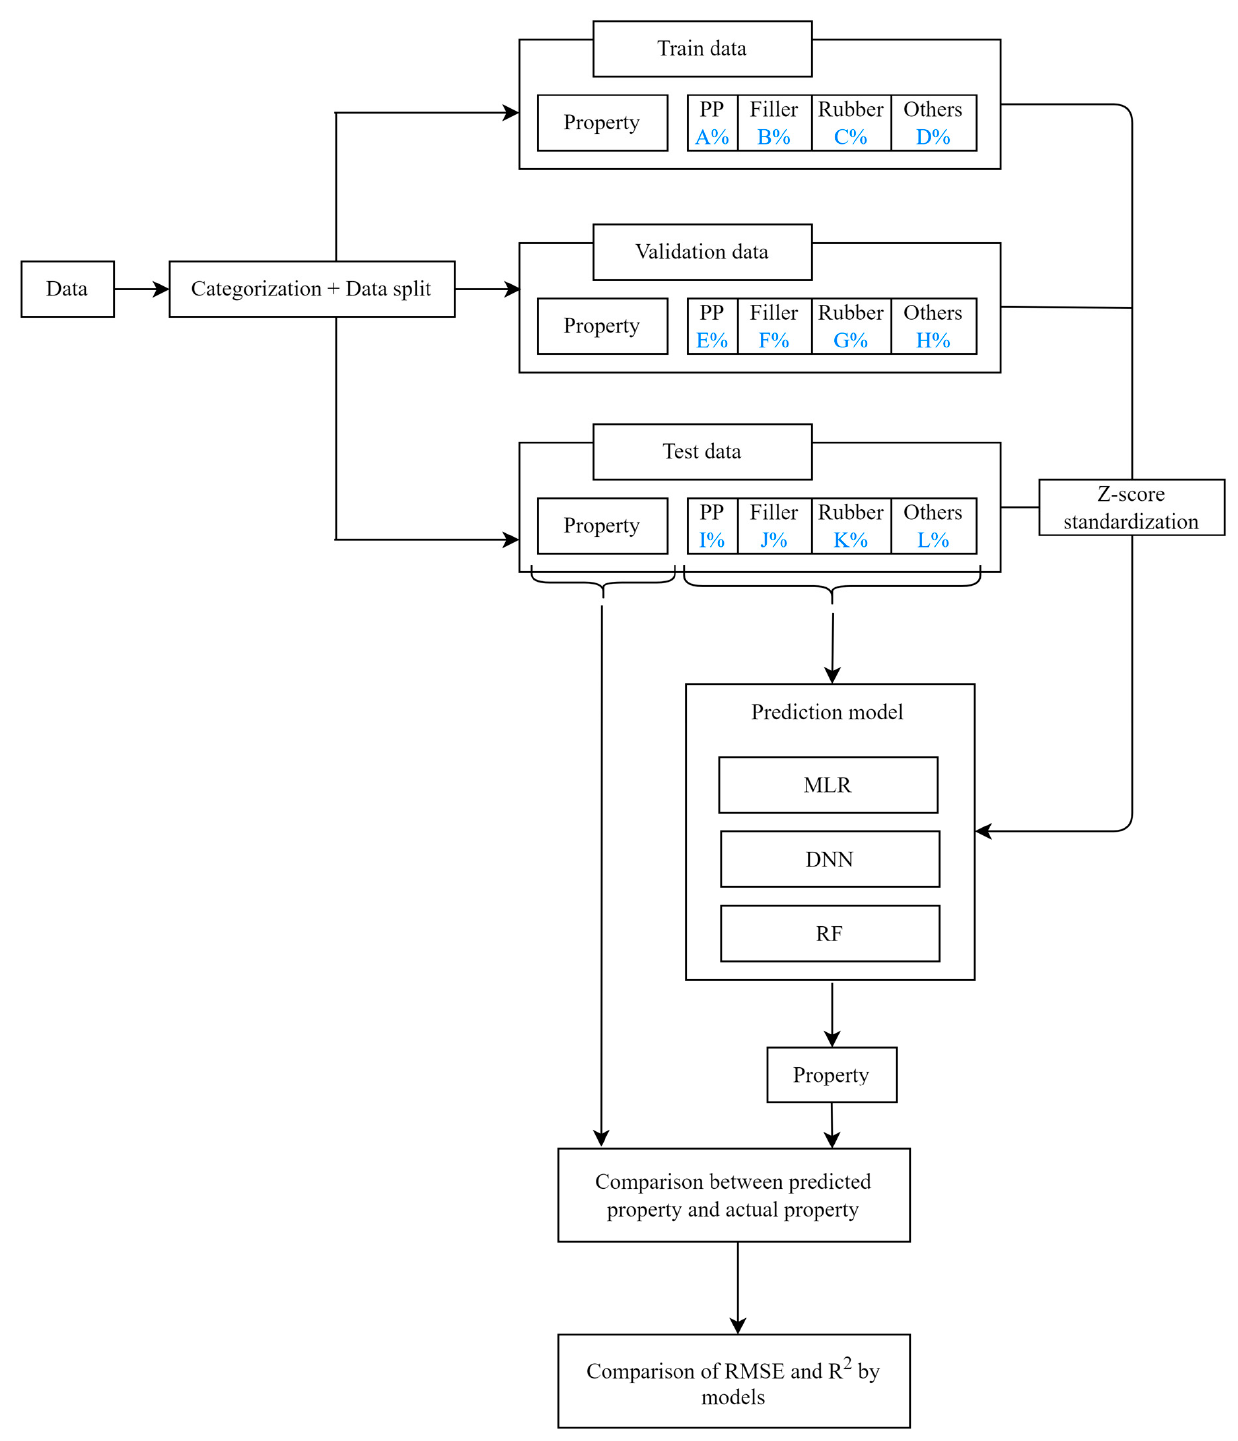
Figure 10. Flowchart of model development.